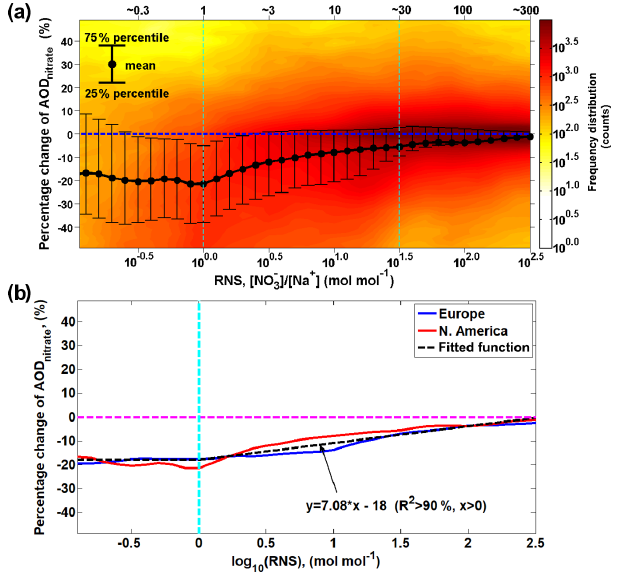
Figure 9. Intensity of redistribution effect as a function of molar ratio between surface fine nitrate and total sodium (RNS). (a) The intensity of the redistribution effect over the North American do- main, similar to Fig. 7a, is calculated as the difference in percentage between AOD nitrate and AOD ∗ in Case_SeasaltOn. AOD ∗ nitrate nitrate indicates the AOD nitrate calculated by reallocating nitrate mass into different size bins according to the normalized nitrate particle mass size distribution simulated in Case_SeasaltOff (i.e., without redis- tribution effect). The black dots indicate the mean values; the upper and lower error bars indicate the 75th and 25th percentiles, respec- tively. The color indicates the frequency distribution (i.e., how many counts) of the hourly model results over the entire North American domain during 10–17 January 2015. (b) The median possibility of the percentage change in AOD nitrate as a function (first-order ap- proximation) of RNS.